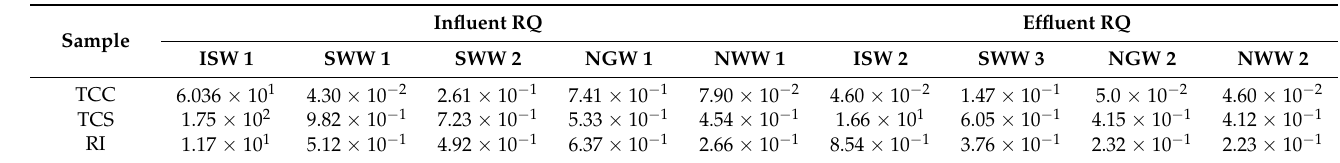
Table 3. Risk quotient (RQ) and risk index (RI) values for TCS and TCC in raw influent and final